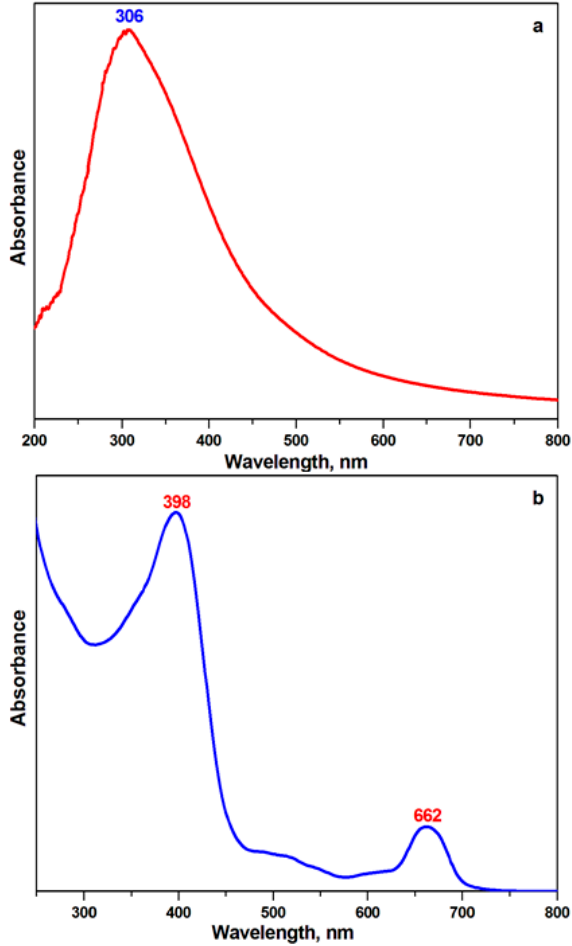
Figure 7. UV–visible spectra in ( a ) absence and ( b ) presence of T. aralioides .